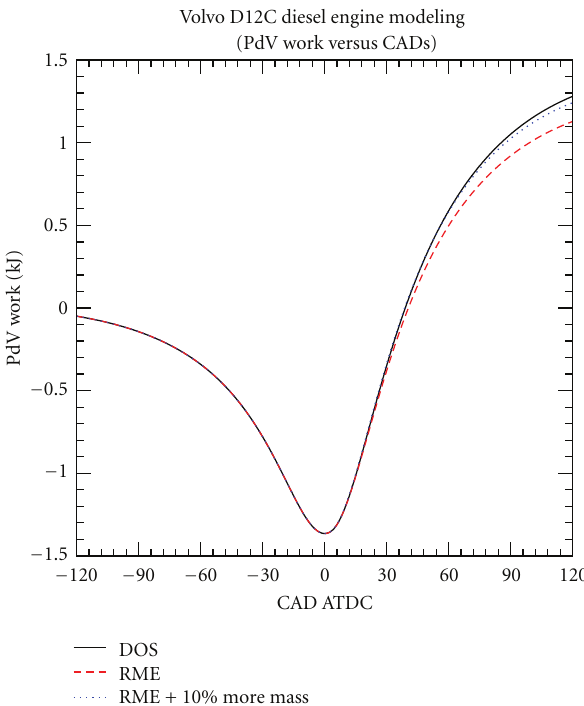
Figure 10: Predicted PdV work for the Volvo D12C diesel engine fuelled by DOS (black solid line), RME (red dashed line) and RME+ (dash-dot line), without EGR.